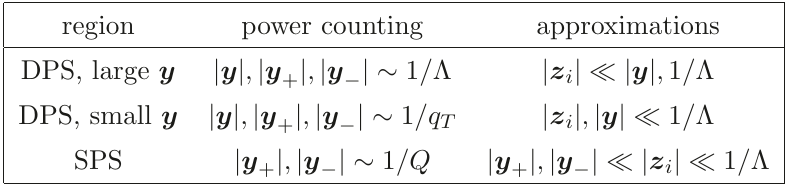
z i 1 /q T is always assumed. | | ∼ C r Γ is good r